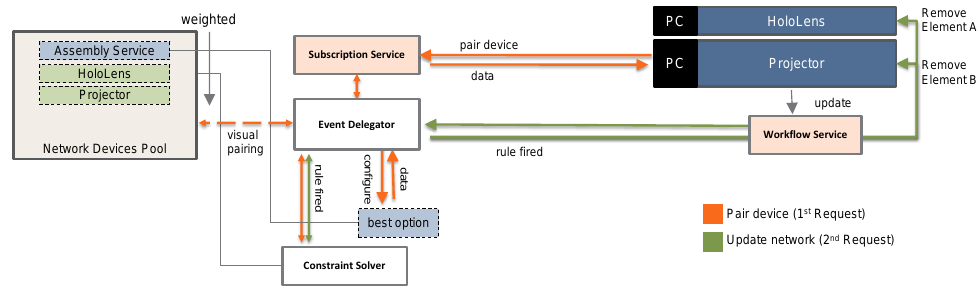
Figure 5. Self-configuration procedure for the first